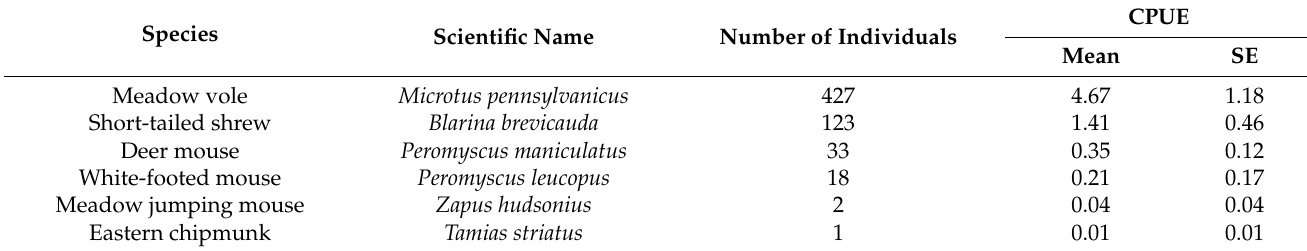
Table 3. Small mammal species assemblage of the riparian zone of Ruby Run at JW Ruby Research Farm in Preston County, West Virginia, USA, from 2017 to 2020. Numbers of unique individuals from each species were combined across years to derive total number of individuals. Average annual number of individuals per 100 trap nights (CPUE) with standard error (SE) were